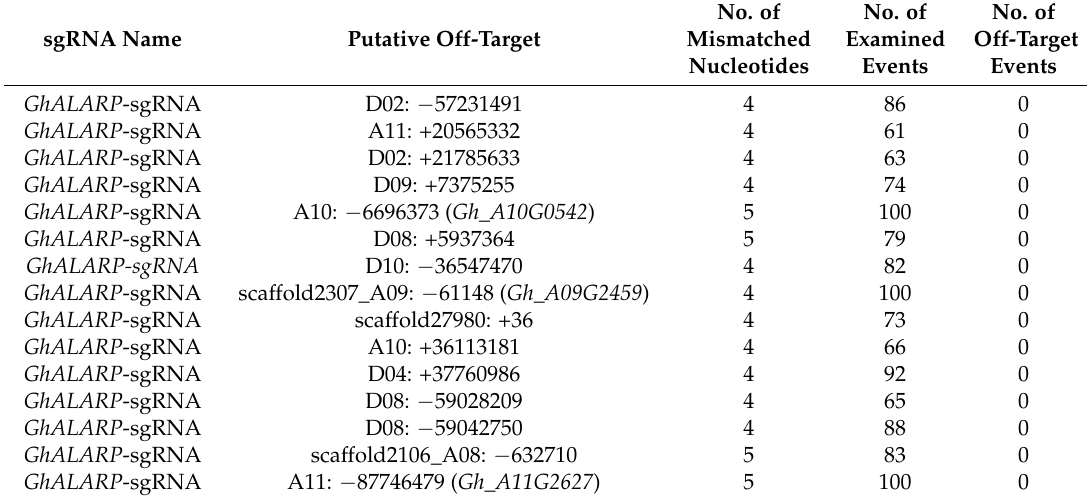
Table 2. Mutation detection and analysis of the 15 potential off-target sites in the 10 independent transgenic cotton